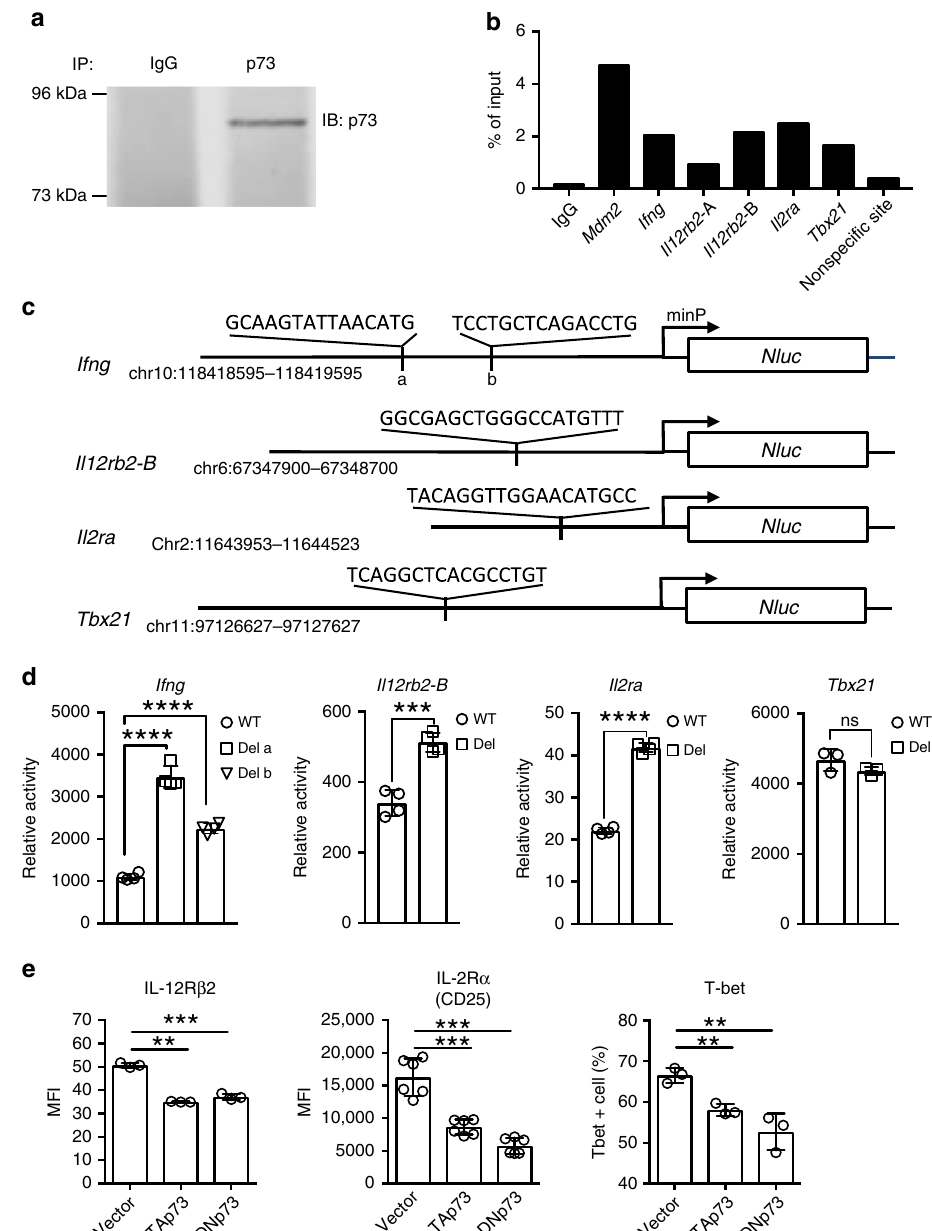
Fig. 5 p73 binding regulates target gene expression. a , b p73 binding at the indicated loci in Th1 cells were assayed by ChIP using anti-p73 antibody versus IgG as a control. p73 protein was immunoprecipitated from Th1 cells and visualized by western blotting with anti-p73 ( a ). A full scan blot image is provided in Supplementary Fig. 9b. The binding was quanti fi ed by qPCR (primers to amplify the sites are in Supplementary Table 7; the nonspeci fi c site is from the Il9 gene). Shown is the percentage of total input ( b ). In b , the experiment was performed n = 3 times n = 2 replicates in each experiment, and representative results are shown. c Schematic of the domain structure of WT and p73-binding motif deletion reporter mutations in the Ifng , Il12rb2 , Il2ra , and Tbx21 loci. p73-binding regions from the indicated chromosomal locations were inserted upstream of minimal promoter (minP) and nano-luciferase gene ( Nluc ). WT reporter constructs retained the indicated p73-binding motifs, whereas the constructs with deletion mutants lacked the indicated nucleotide sequences. For Ifng , two deletion mutants were generated — one lacking the a motif and the other lacking the b motif. For Il12rb2 , we tested a deletion mutant corresponding to the peak B motif. d The indicated reporter constructs containing WT or p73-binding motif deletion mutants were transfected into Th1 cells. Reporter activity was normalized against co-transfected control luciferase reporter construct activity and shown as relative activity. e The level of IL-12R β 2, IL-2R α (CD25), and T-bet in Th1 cells expressing control vector, TAp73, or DNp73 was measured by fl ow cytometric staining and shown as MFI. In d , e , experiments were repeated n = 3 times. In the experiment shown in d , the number of replicates was n = 4 for Ifng , Il12rb2 -B, and Il2ra and n = 3 for Tbx21 . In the experiment shown in e , the number of replicates was n = 3 for IL-12R β 2 and T-bet and n = 6 for IL-2R α . Representative results are shown. All data are shown as mean value ± SD and analyzed by a two-tailed unpaired t test. The P values are indicated (** P < 0.01; *** P < 0.001; **** P < 0.0001). Source data for a , b , d , and e are provided in Source Data